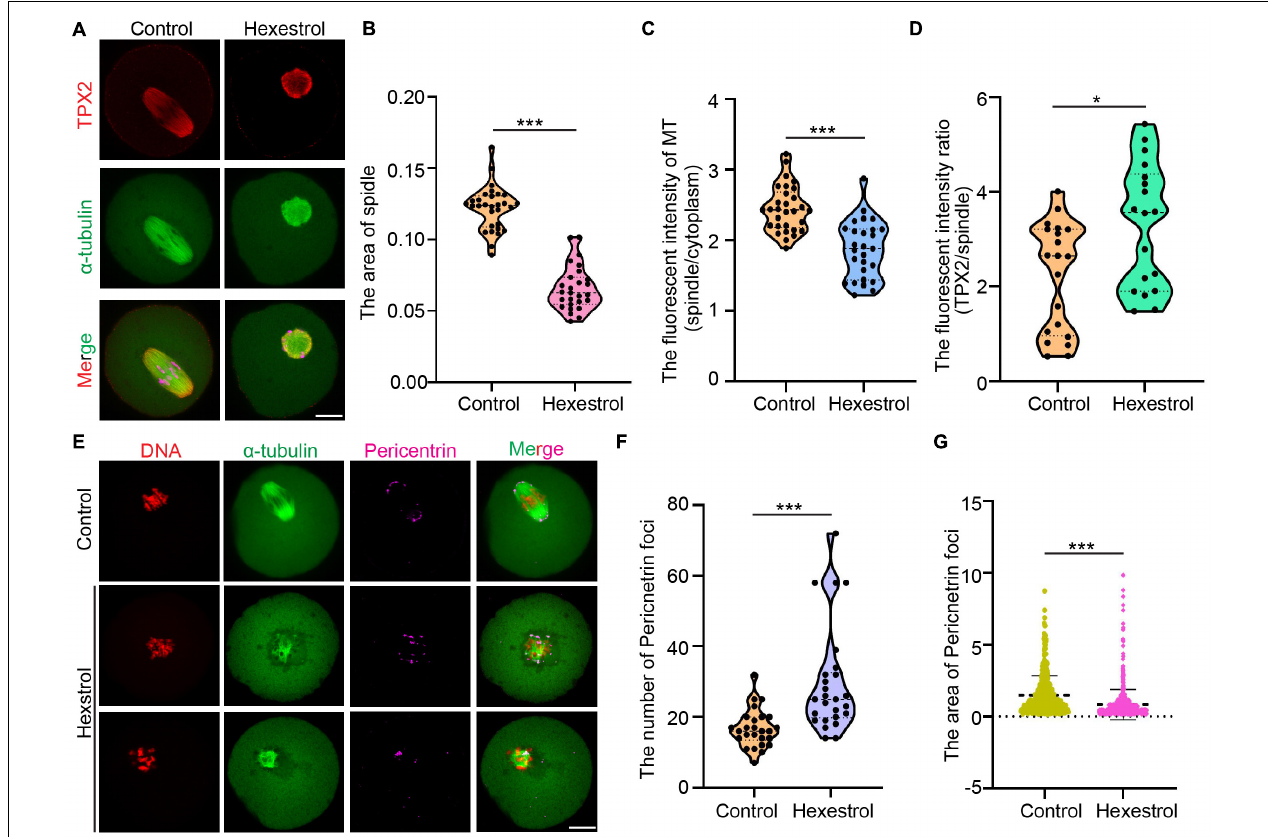
FIGURE 3 | HES disturbs MT assembly and coalescence of MTOCs in MI spindle poles. P < 0.001. (A) Representative images of TPX2 localization in control and HES-exposed oocytes. Scale bar, 20 µ m. (B) Spindle area was quantified in control and HES-exposed oocytes. *** P < 0.001. (C) Ratio of MT fluorescent intensity in spindle and cytoplasm was quantified in control and HES-exposed oocytes. *** P < 0.001. (D) Ratio of TPX2/spindle fluorescent intensity was recorded in control and HES-exposed oocytes. * P < 0.05 and *** P < 0.001. (E) Representative images of spindle morphologies and pericentrin localization in control and HES-exposed oocytes. Scale bar, 20 µ m. (F,G) Number and area of pericentrin foci were quantified in control and HES-exposed oocytes. *** P < 0.001. Data are represented as mean ± SD from at least three independent